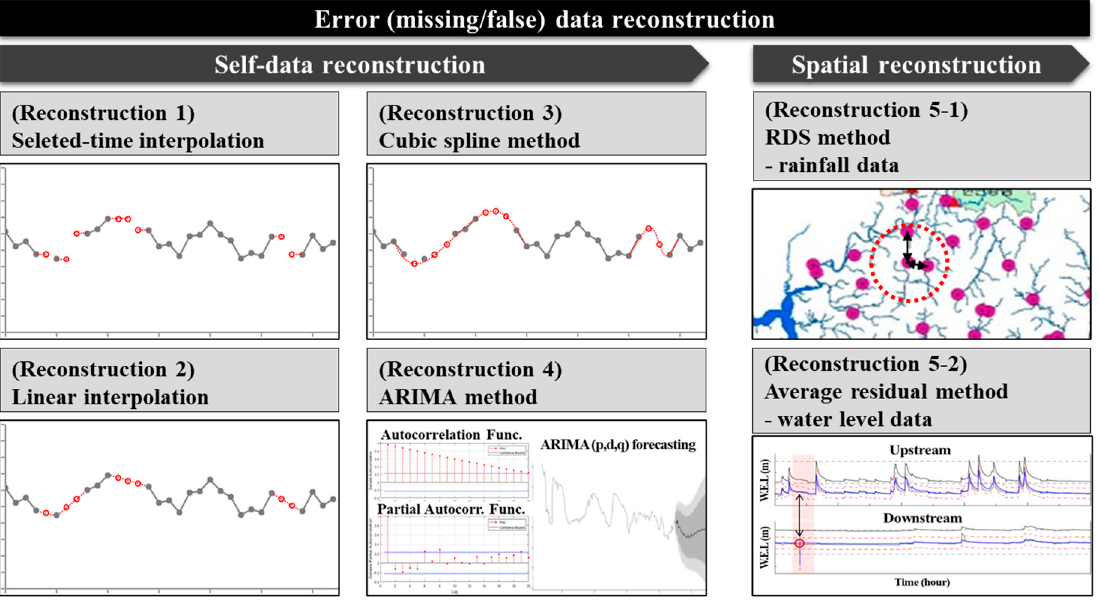
Figure 4. Conceptual diagram of the applied six data reconstruction methods.